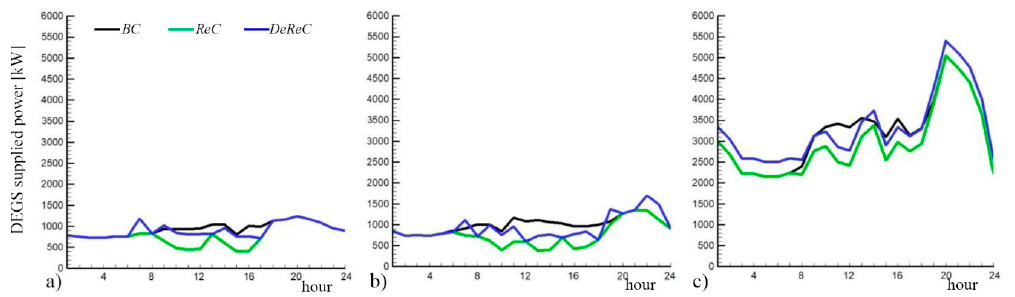
Figure 8. Hourly based curves for water reserve (left axis, black line) and water supply deficit (right axis, grey line) in DeReC during a reference year.